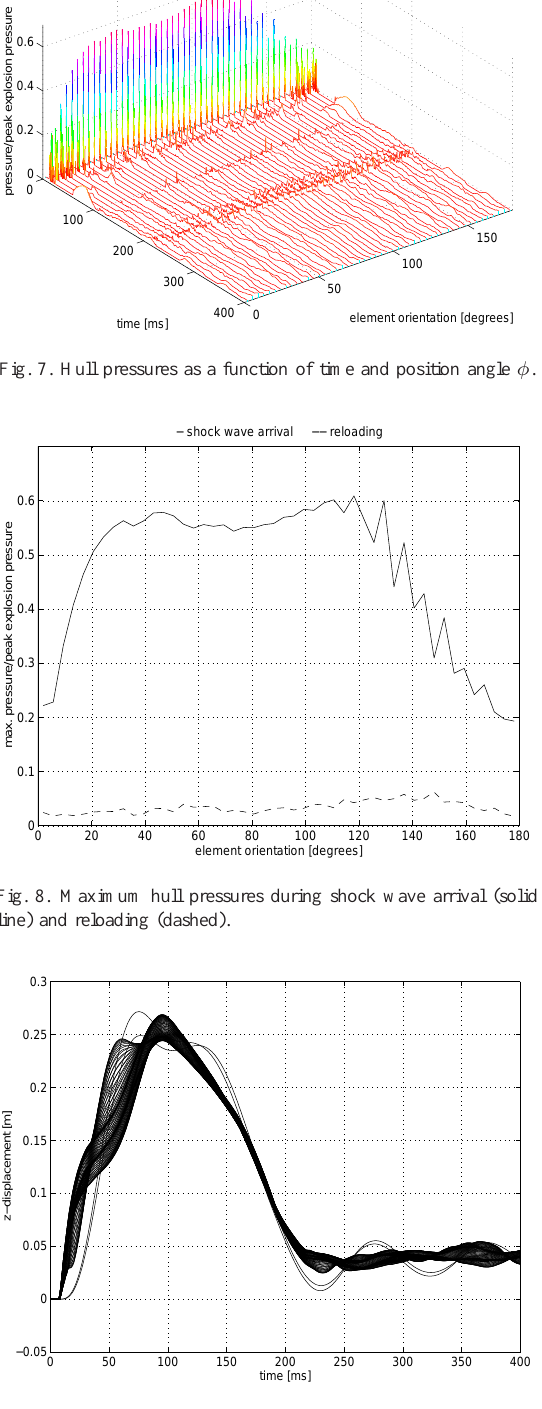
Fig. 9. Vertical displacements of hull nodes as a function of